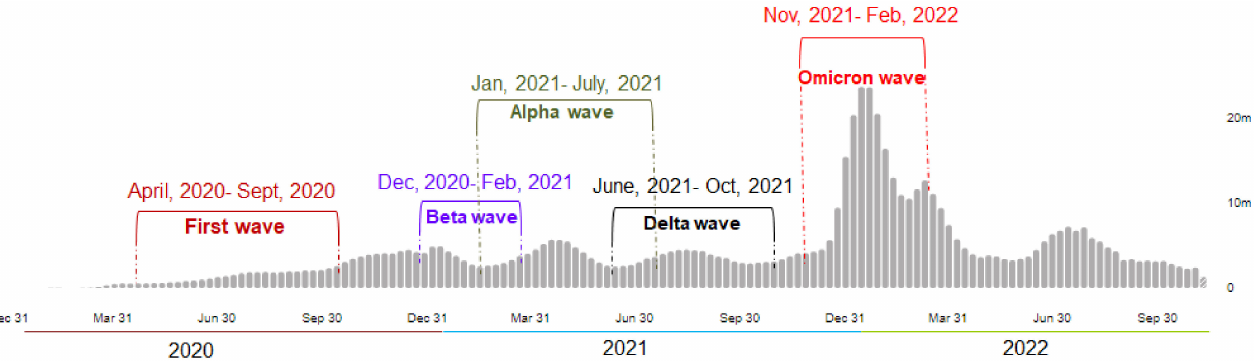
Figure 2. The new wave generated due to high infection worldwide due to Omicron’s infection. The new wave is called the Omicron wave. The peak of the Omicron wave is very high compared to the other waves, such as the Alpha wave and the Beta wave,